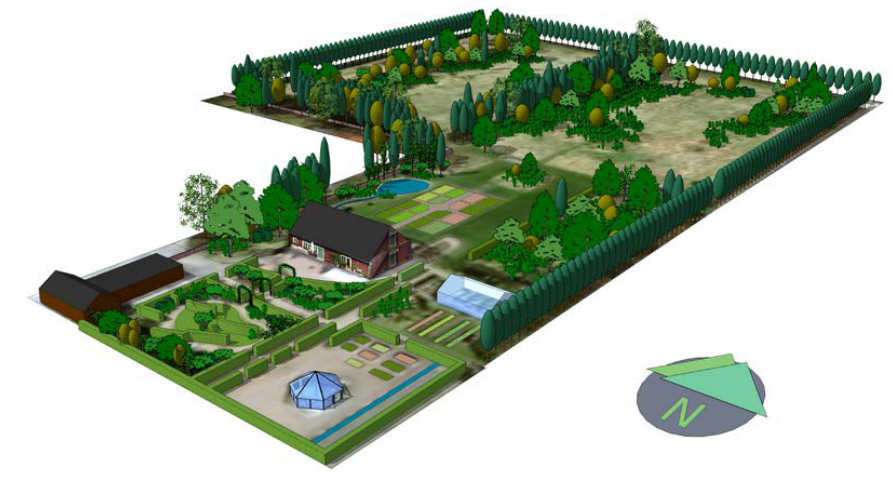
Figure 1. 3D sketch depicting the Alnarp rehabilitation garden. Image rendered by: Gunnar Cerwén.